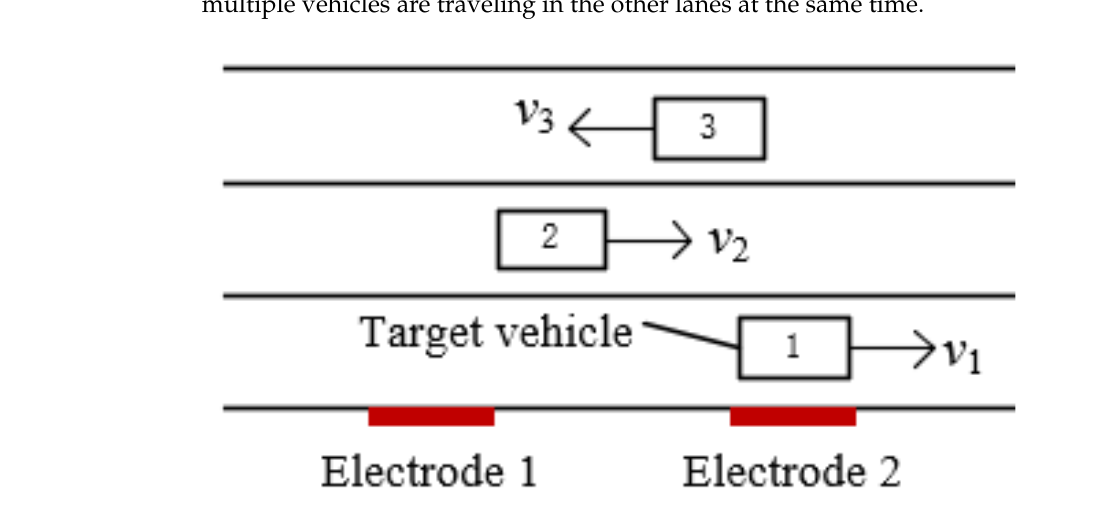
Figure 15. Simulation results of vehicles driving close together: ( a ) simulation results; ( b ) cross-correlation results of vehicle 1; ( c ) cross-correlation results of vehicle 2.